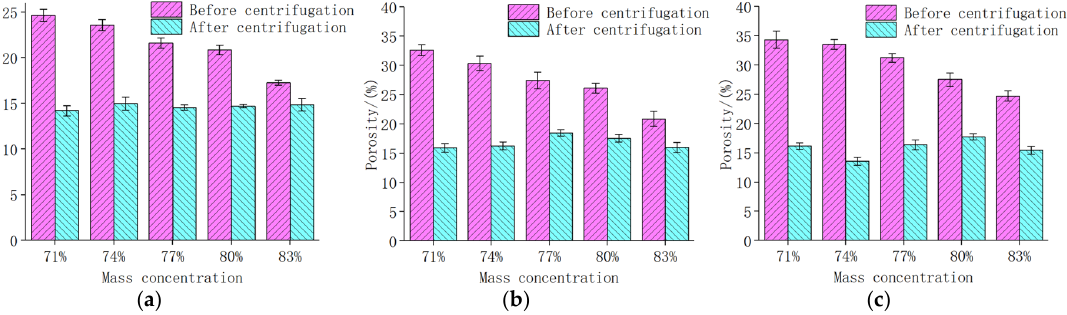
Figure 6. Analysis of backfill porosity with different concentrations and ratios before and after centrifugation. ( a ) cement–tailings ratio of 1:4; ( b ) cement–tailings ratio of 1:8; ( c ) cement–tailings ratio of 1:12.